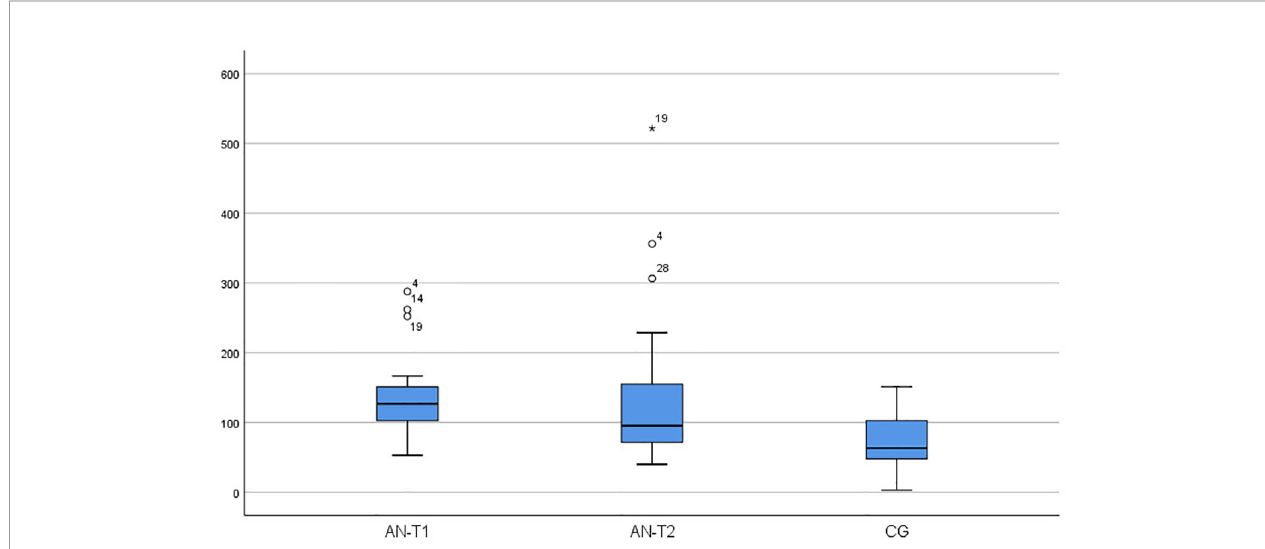
FIGURE 1 | Serum oxytocin (OXY) concentration in the adolescent anorexic inpatients in acute stage of the disease (AN-T1) as well as after partial weight normalization (AN-T2), and in the control group (CG).